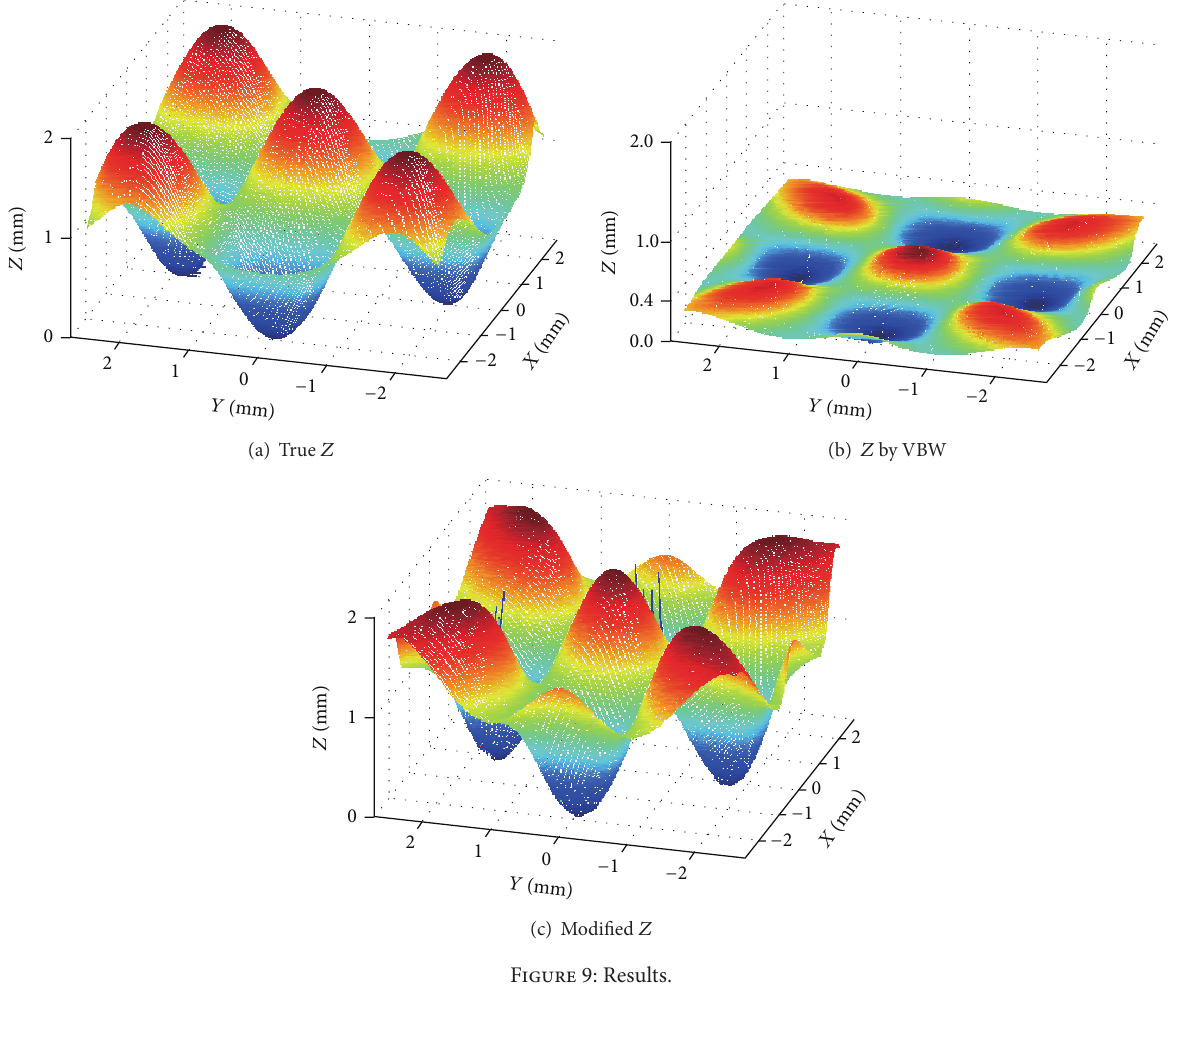
Figure 9: Results.